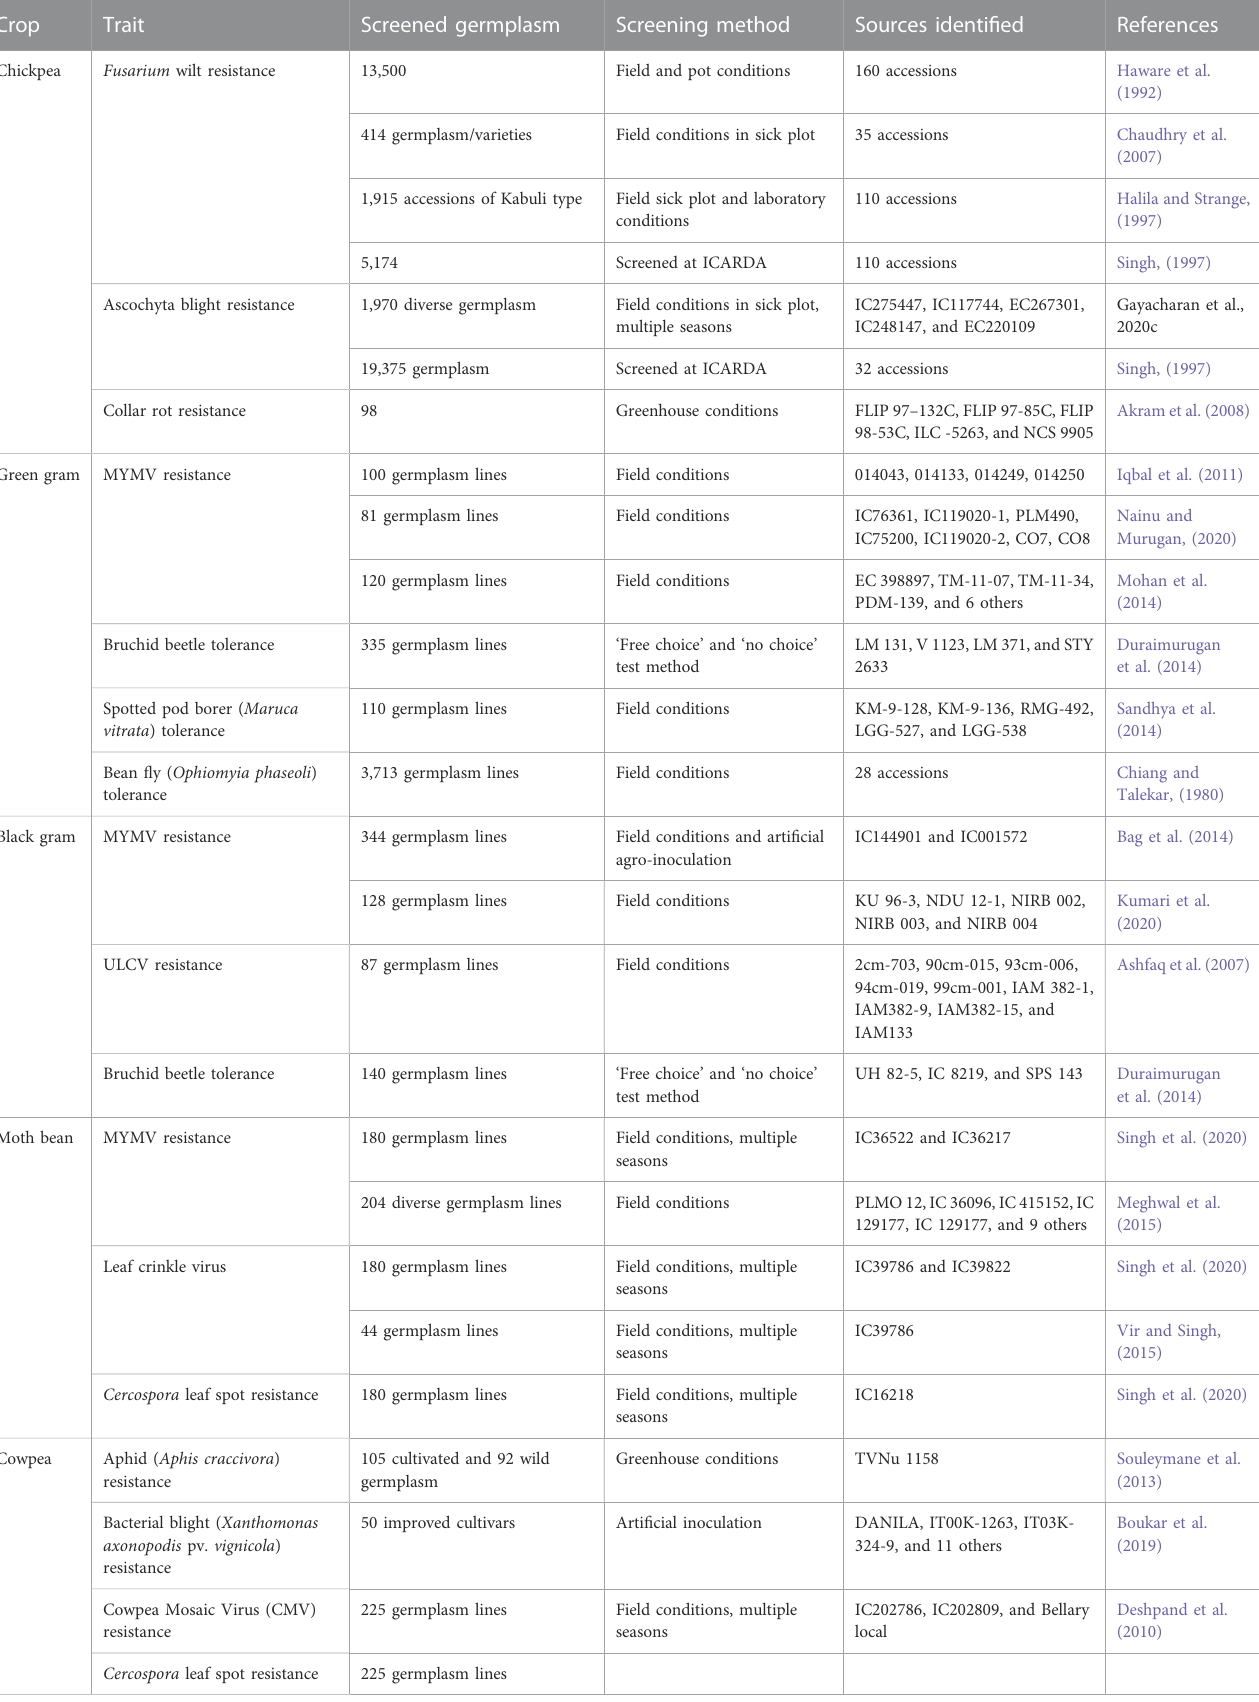
TABLE 4 List of important resistance sources identi fi ed for various important biotic stresses in grain legume